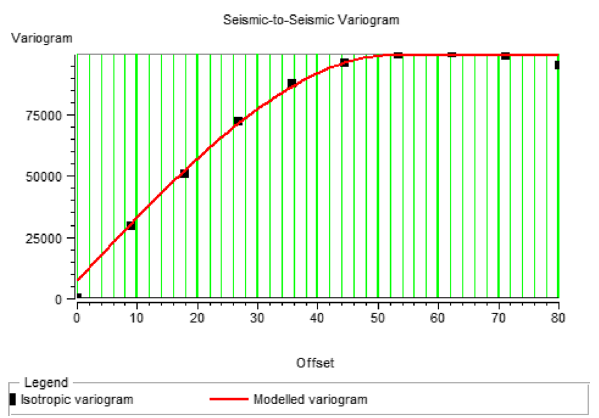
Fig. 28 Spatial structure of the third seismic data